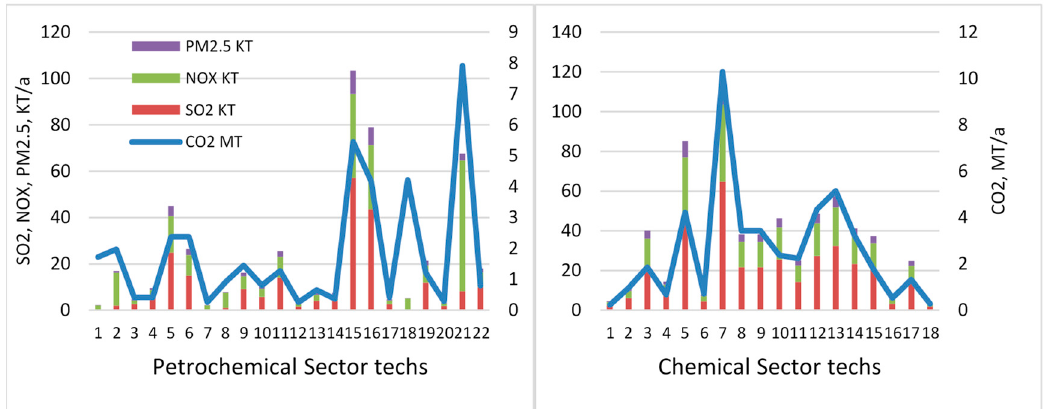
Figure 7. Annual emission reduction potential of CO 2 and air pollutants.